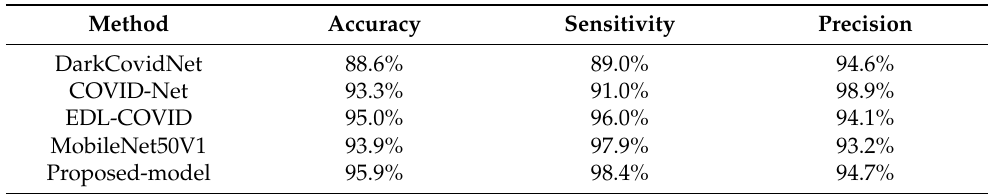
Table 2. Detection performance comparison among three state-of-the-art methods, our based-line MobileNet50V1, and the proposed